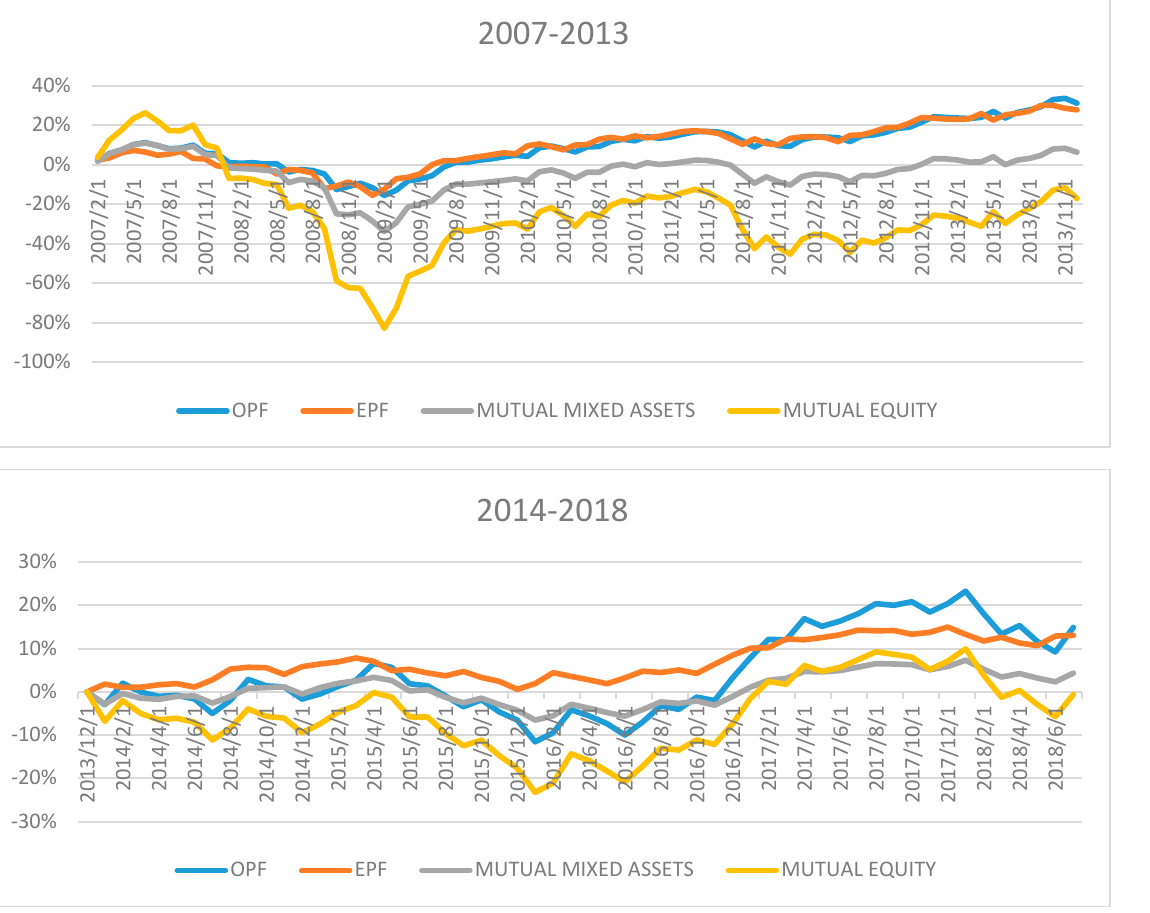
Figure 3. Cumulative continuous return of equal-weighted portfolios of pension funds and mutual funds in Polish pension system.